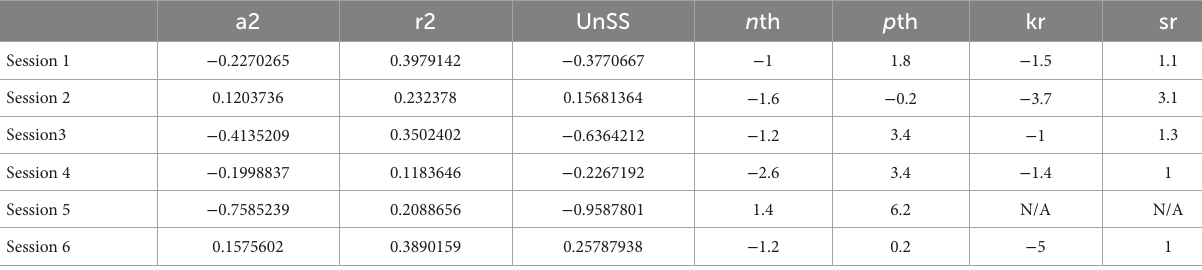
TABLE 4 Dynamical systems model parameters for Aimee.